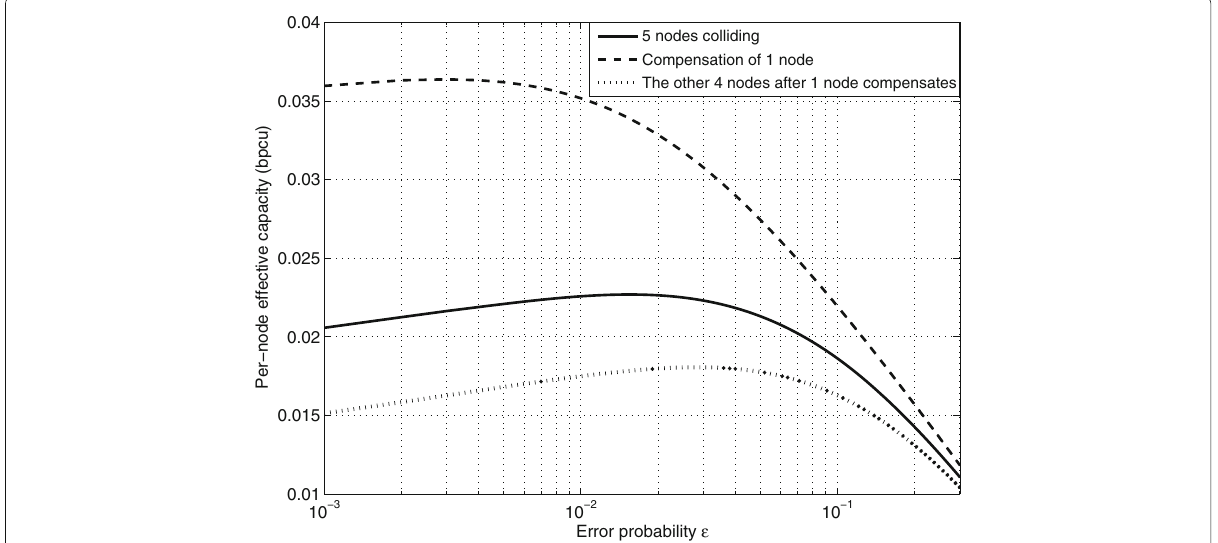
Fig. 4 Compensation via power control. Per-node effective capacity as a function of error outage probability (cid:2) with T f = 1000, θ = 0.1, and ρ =